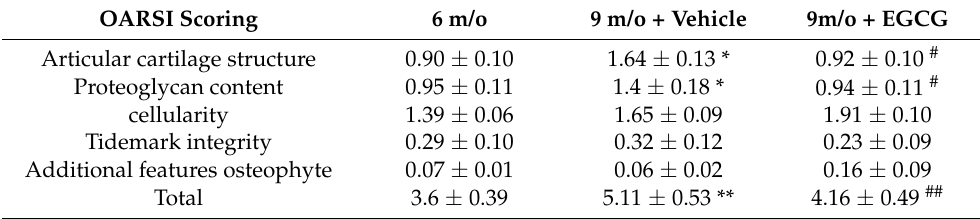
Figure 6. The results of histological analysis of OA and the quantitative assessment of glycosamino- glycan (GAG) loss. ( A ). The representative micrographs of the proximal tibial cartilage with safranin O–Fast Green staining. ( B ). The 9-month-old animals and the cartilage degrading features were decreased after EGCG treatment. Moreover, there was significantly better GAG preservation in the EGCG-treated knee compared with the contralateral untreated knee of animals at 9 months of age ( n = 8 in each group; ** p < 0.01 versus animals at 6 months of age; ## p < 0.01 versus animals treated with PBS at 9 months of age; ++ p < 0.01 versus the contralateral knee). Table 2. OARSI